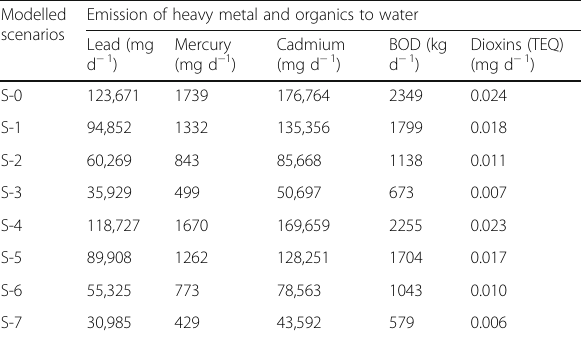
Table 8 Emission of heavy metal and organics to water in